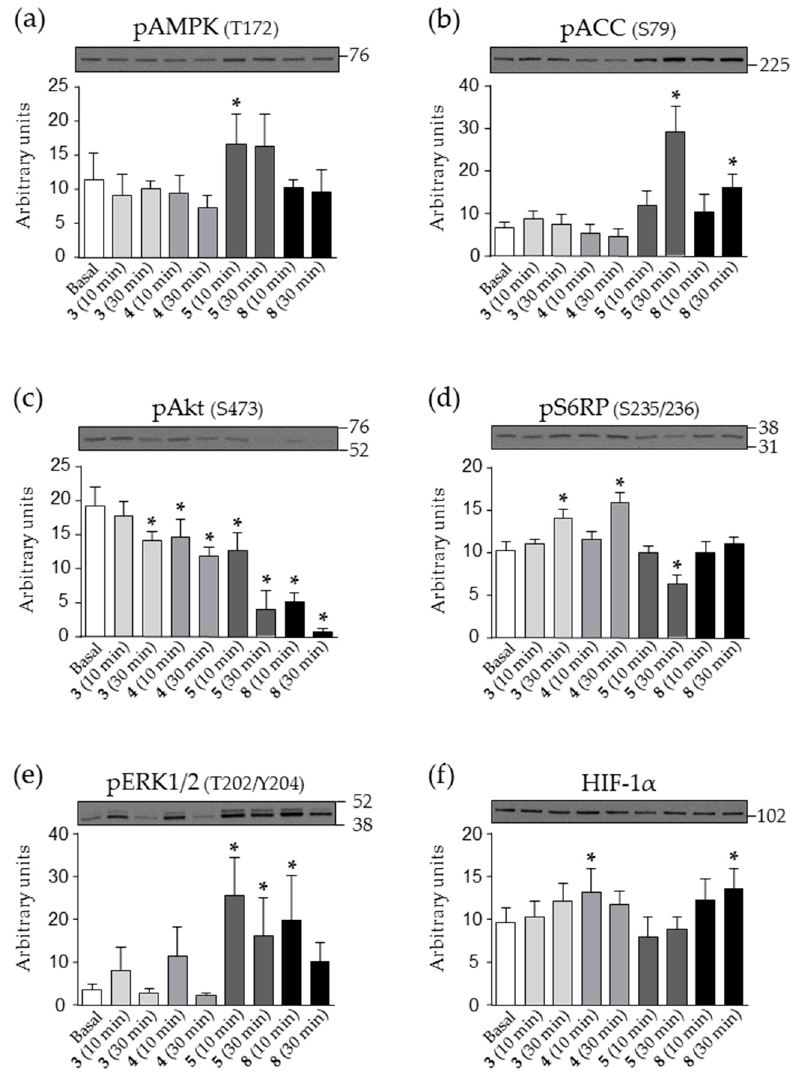
Figure 5. Time-dependent effects of nicotinamide derivatives on intracellular signalling in HEK293 cells. Serum-starved HEK293 cells were treated with 100 µ M 3 , 4 , 5 or 8 for 10 or 30 min as indicated. Immunoblotting was used to estimate ( a ) phospho-AMPK (Thr172), ( b ) phospho-ACC (Ser79), ( c ) phospho-Akt (Ser473), ( d ) phospho-S6RP (Ser235/236), ( e ) phospho-ERK1/2 (Thr202/Tyr204), ( f ) HIF-1 α . Results are presented as means ± SD ( n = 6). * p < 0.05 vs. Basal (ANOVA followed by Dunnett’s post hoc test).